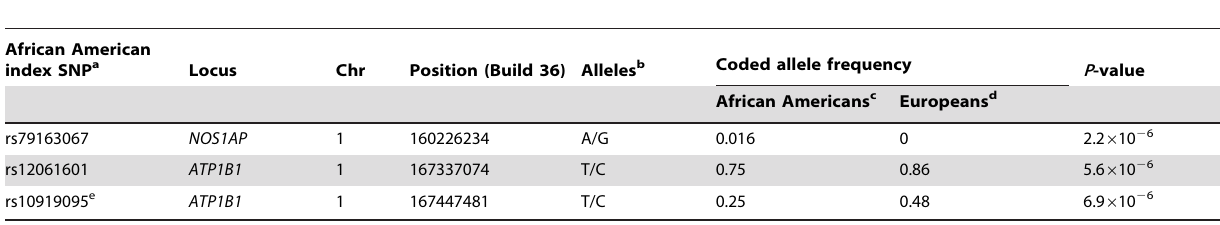
Table 2. Novel and independent SNPs associated with QT at two previously identified QT loci in n =8,644 African American participants.